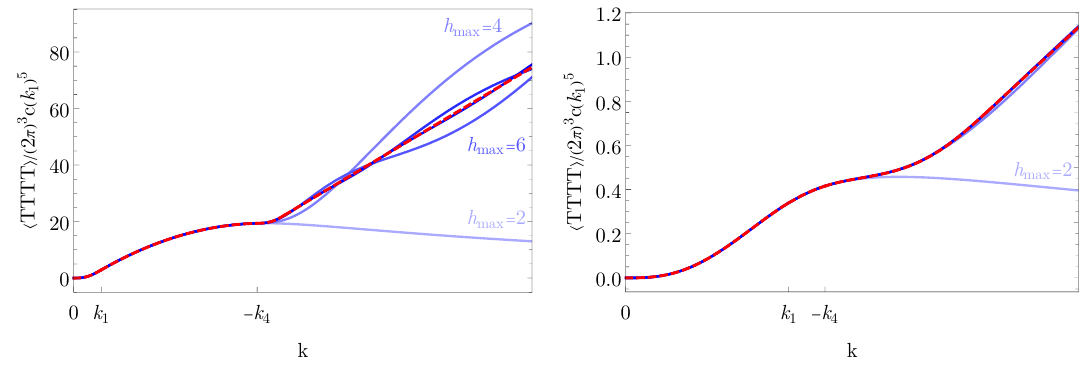
TTTT given by eq. (4.8) as a h i k 4 (left panel) and the other in (cid:28) (cid:0)